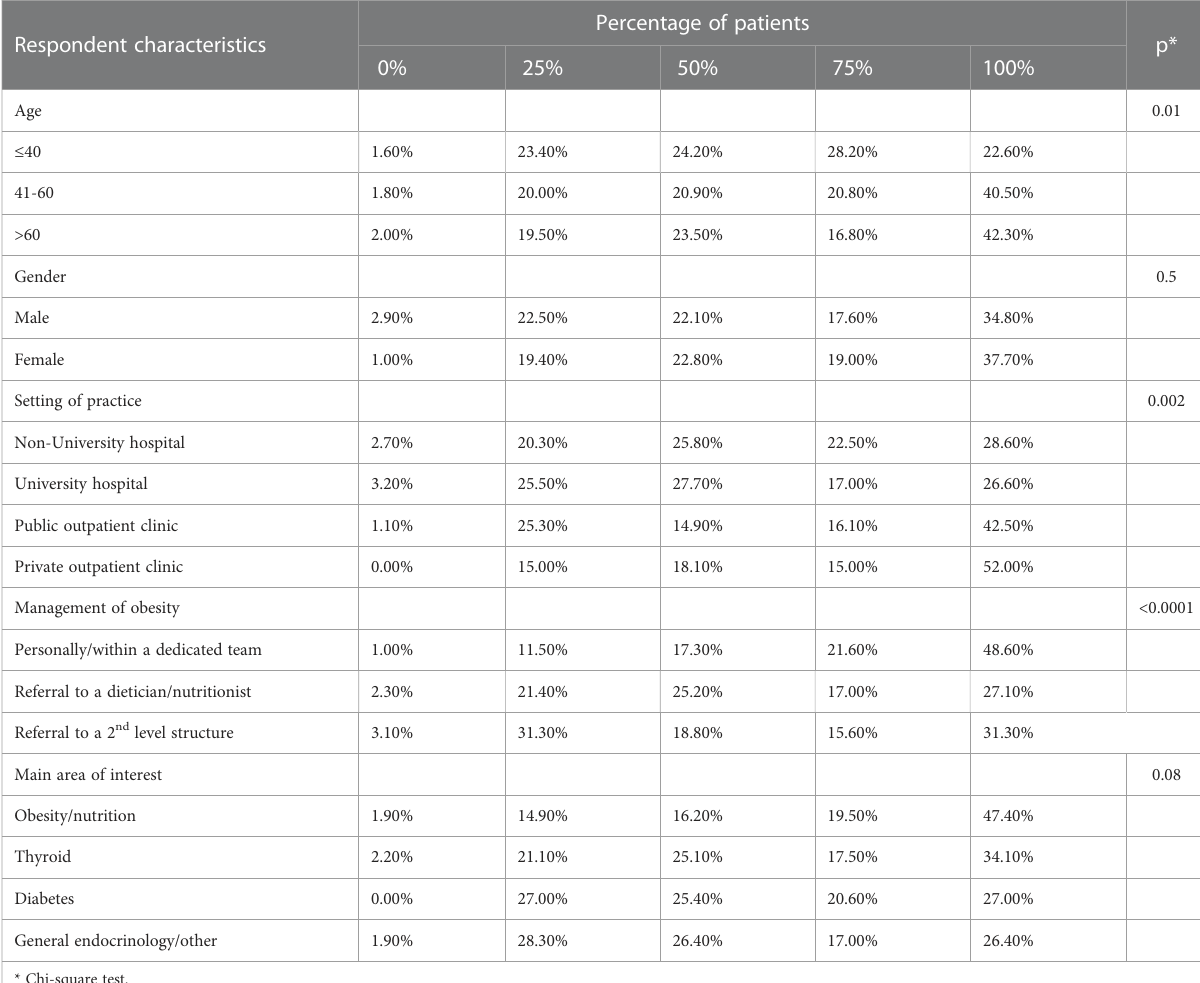
TABLE 3 Reported percentage of patients with obesity presenting for another problem in whom the obesity problem is addressed, by respondent